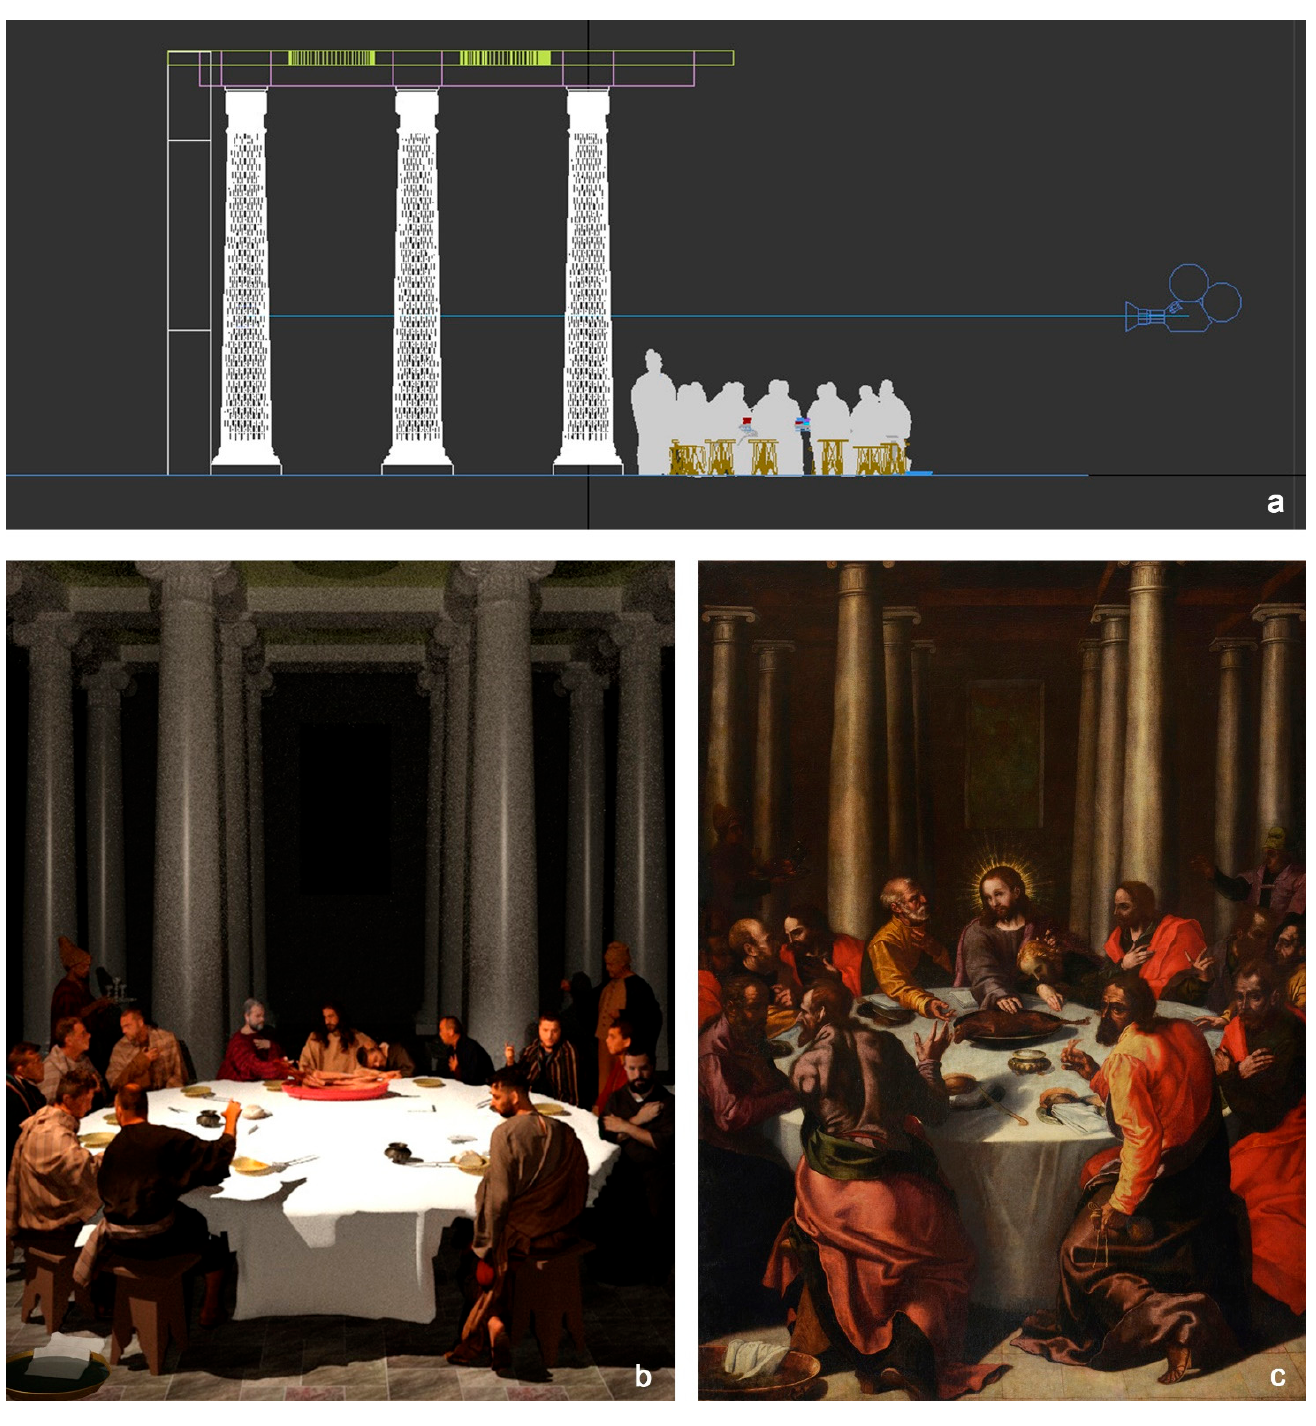
Figure 13. ( a ) Side view of the scene with indication of the position of the camera at 2.25 m from the ground (25 mm camera); ( b ) image taken from the reconstruction of the virtual model; ( c ) G. Hovic, Last Supper.